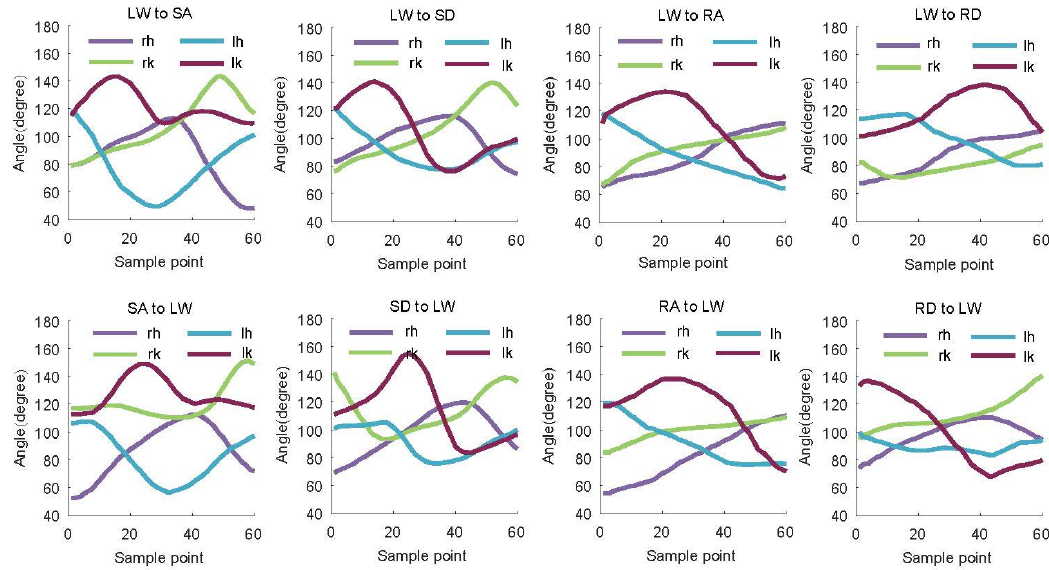
Figure 6. The angle signals of both legs sensor with eight transition